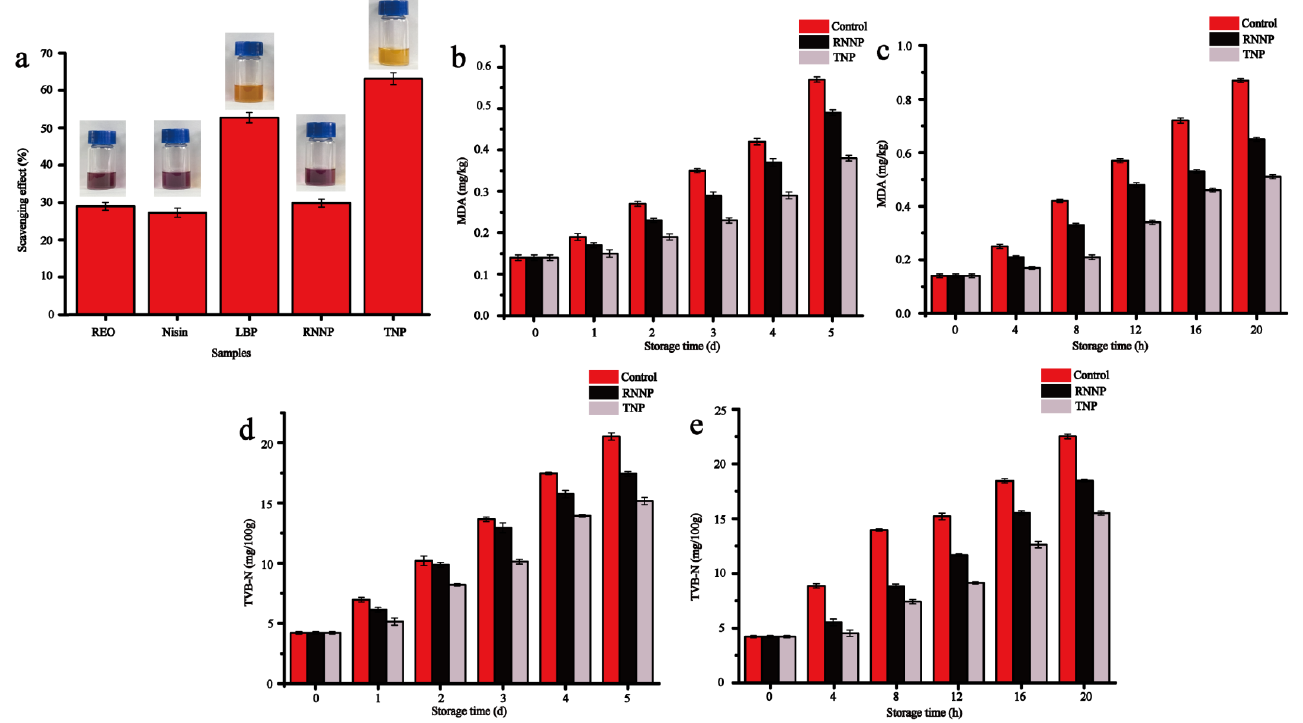
Figure 6. The antioxidation effect of nanoparticles including DPPH free radical scavenging capacity ( a ), TBA ( b , c ) and TVB-N ( d , e ) at 4 °C and 25 °C.